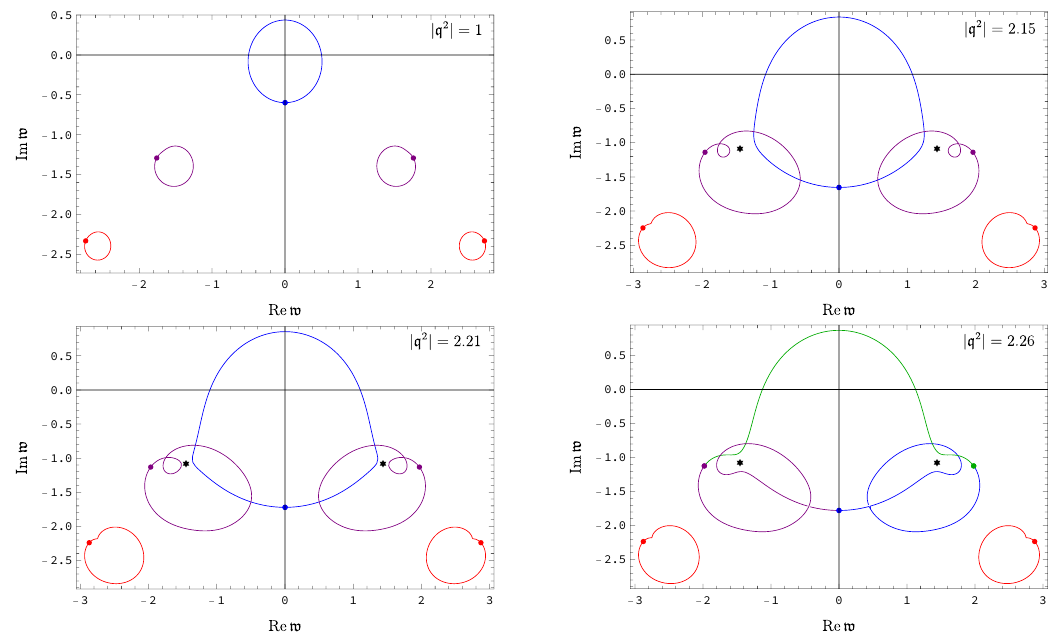
Figure 7 . Quasinormal spectrum (poles of the retarded energy-momentum tensor two-point func- tion in the N = 4 SYM theory) in the shear channel plotted in the complex w -plane for di(cid:11)erent values of the complex momentum q 2 = j q 2 j e i(cid:18) . Large dots in all four plots correspond to the loca- tion of the poles for purely real momentum, q 2 (i.e. at (cid:18) = 0) [41]. The hydrodynamic shear pole is the blue pole closest to the real axis in the top left panel. As (cid:18) increases from 0 to 2 (cid:25) , each pole moves in a counter-clockwise direction, following the trajectory of its colour. At j q 2 j = 1, all poles follow a closed orbit (top left panel). At j q 2 j = 2 : 15 (top right panel), the trajectory of the hydrodynamic pole intersects the trajectories of the two nearest gapped poles. With j q 2 j further increasing to j q 2 j = 2 : 21, the poles nearly collide at the positions marked by asterisks (bottom left panel). The actual collision occurs at the critical point with the momentum (4.20), j q 2 j (cid:25) 2 : 224. c At j q 2 j = 2 : 26 (bottom right panel), the orbits of the three poles closest to the origin ( w = 0) are no longer closed: the hydrodynamic pole and the two gapped poles exchange their positions cyclically as the phase (cid:18) increases from 0 to 2 (cid:25) . This is a manifestation of the quasinormal mode level-crossing. The dispersion relation w ( q 2 ) therefore has branch point singularities in the complex momentum squared plane at q 2 c